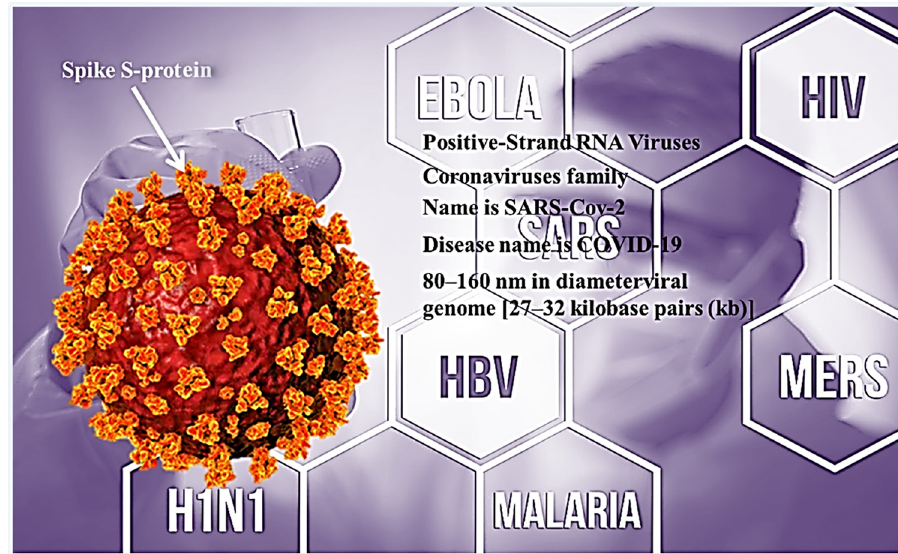
Figure 1: Structure and information of SARS - CoV -